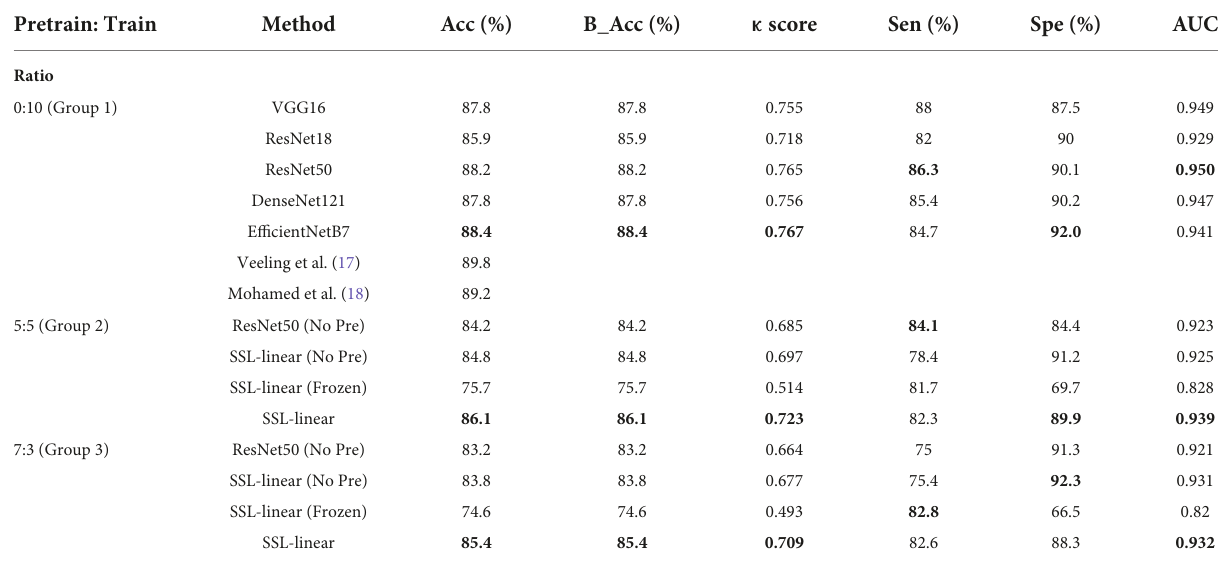
TABLE 2 Results of classification task in Patchcamelyon